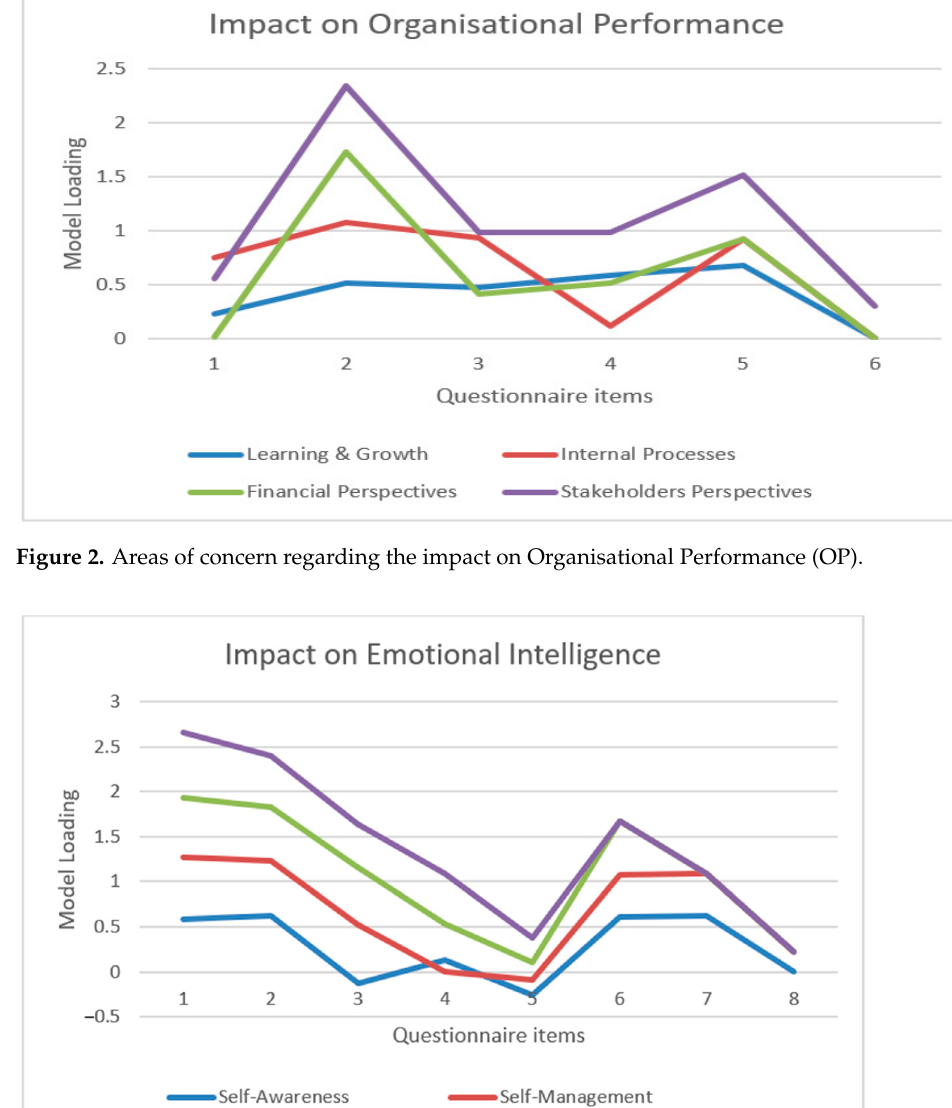
Figure 2. Areas of concern regarding the impact on Organisational Performance (OP).